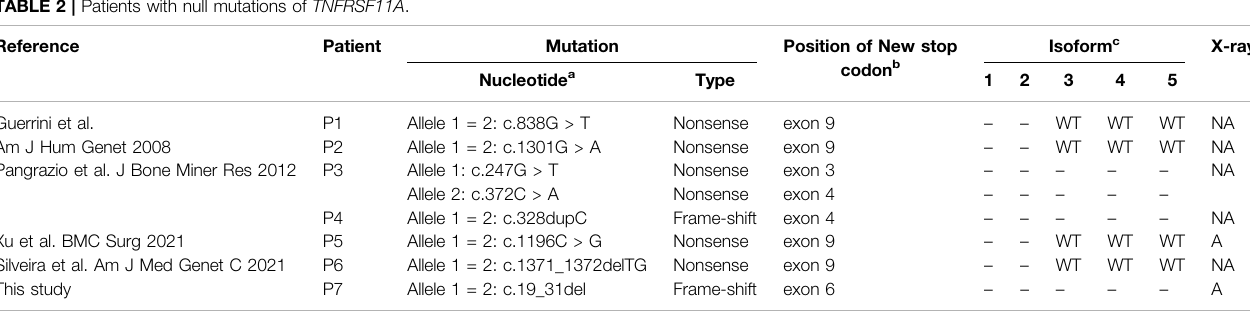
TABLE 2 | Patients with null mutations of TNFRSF11A .